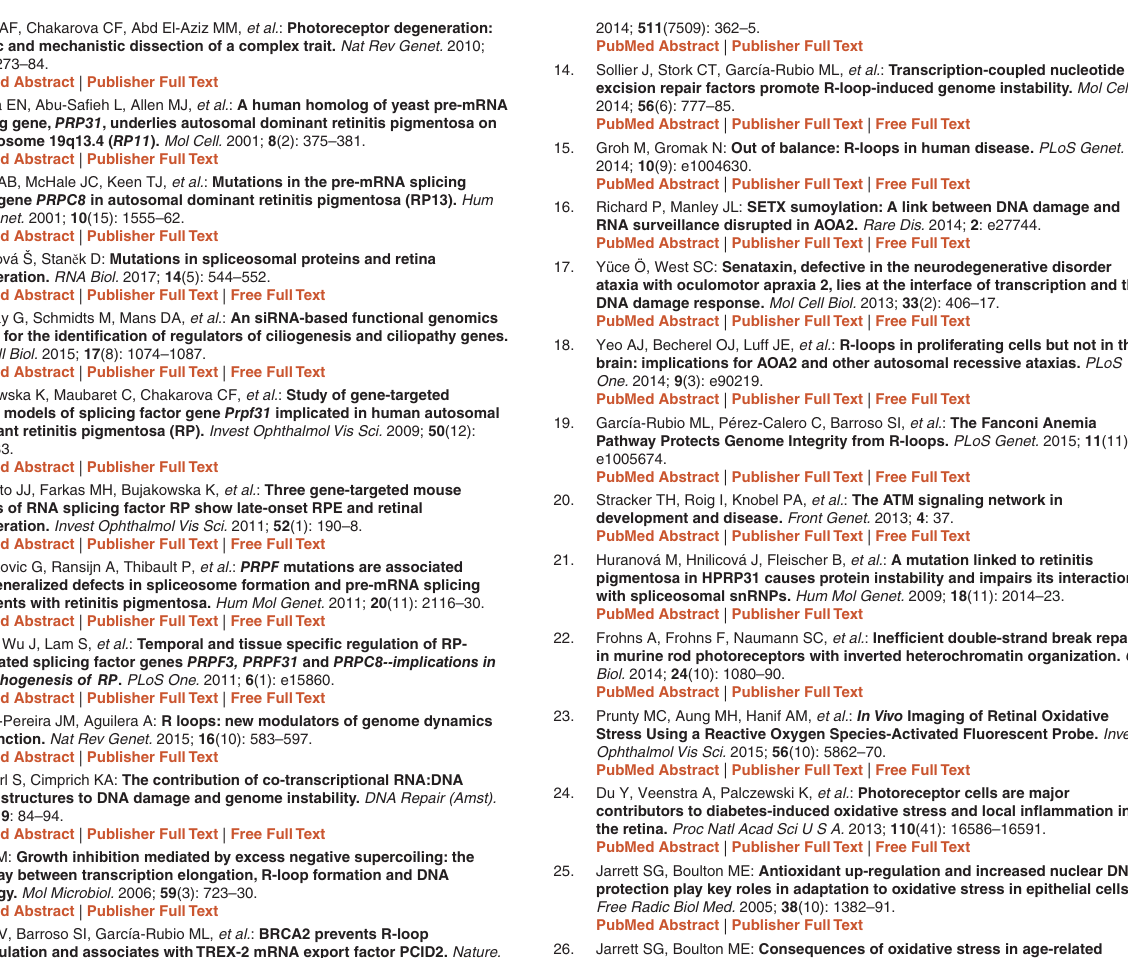
Supplementary Figure 5. Effect of stabilizing RNA:DNA hybrids by hybrid-binding (HB) domain expression on cell cycle . The HB domain was expressed in RPE-1 (upper panel) and HT1180 cells (lower panel). RPE-1 cells show S-phase accumulation and HT1180 cells show the presence of a sub-G1 population in the presence of the HB domain. Click here to access the data. Supplementary Figure 6. Immunofluorescence analysis of human retinal section. (a) S9.6 staining to detect RNA:DNA hybrids. The outer nuclear layer (ONL) and inner nuclear layer (INL) are labeled. (b) ATM and 53BP1 expression analyzed by immunofluorescence in human photoreceptor nuclei. Click here to access the data. Supplementary Figure 7. RNA:DNA hybrids stimulate the DNA damage response. ATM activation and RNA:DNA hybrid formation are interdependent events and important for DNA repair response during oxidative stress. The model shows that RNA:DNA-hybrids (RNA (orange) and template DNA (red)), are sites for ATM binding and activation. We speculate that cells could dissolve RNA:DNA hybrids using enzymes like RNaseH (right panel) or suppress ATM-expression (left panel) to fine-tune ATM-dependent signaling in DNA repair and cell death. Click here to access the